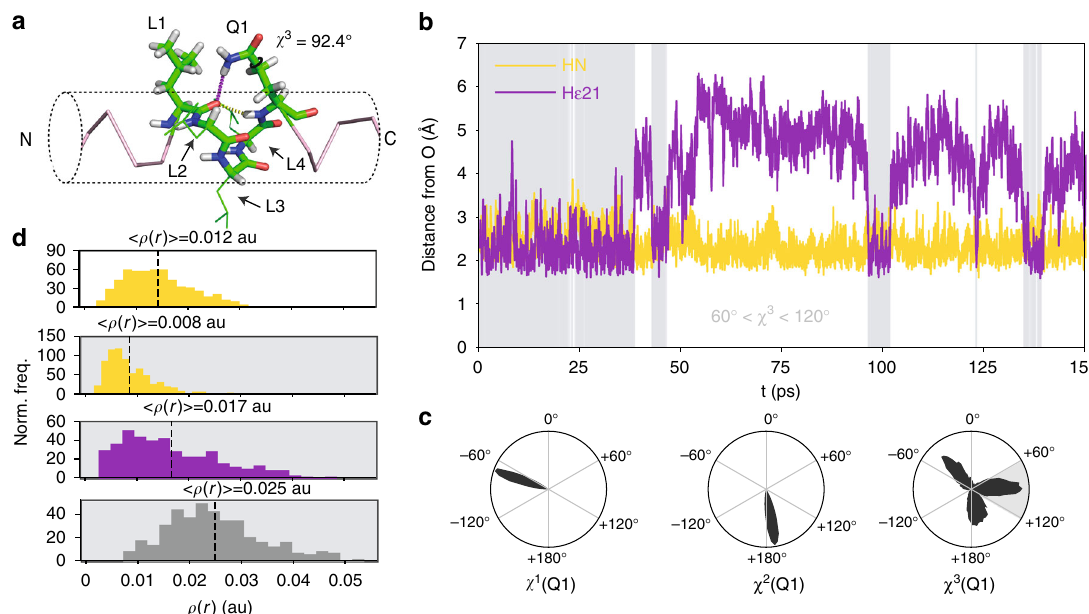
Fig. 6 The sc( i ) → mc( i − 4) and mc( i ) → mc( i − 4) hydrogen bonds are bifurcate. a Starting con fi guration used in the simulation, with the atoms included in the QM subsystem shown as sticks and the distances plot in b shown as dashed lines. b Time series of the distances between donor and acceptor for the mc(Q1) → mc(L1) and sc(Q1) → mc(L1) interactions, with an indication, in a gray background, of the frames for which 60° < χ 3 < 120°. c Distributions of the χ 1 , χ 2 , and χ 3 dihedral angles of the side chains of Q1 with an indication, as a gray shade, of the range of values of χ 3 that are compatible with the sc(Q1) → mc(L1) hydrogen bond. d Distribution, plotted as a normalized histogram, of the electron density ρ ( r ) corresponding to the mc(Q1) → mc(L1) interaction (yellow) in the absence (white background) and in the presence (gray background) of the sc(Q1) → mc(L1) interaction and of the electron density corresponding to the sc(Q1) → mc(L1) interaction (purple) and bifurcate interactions